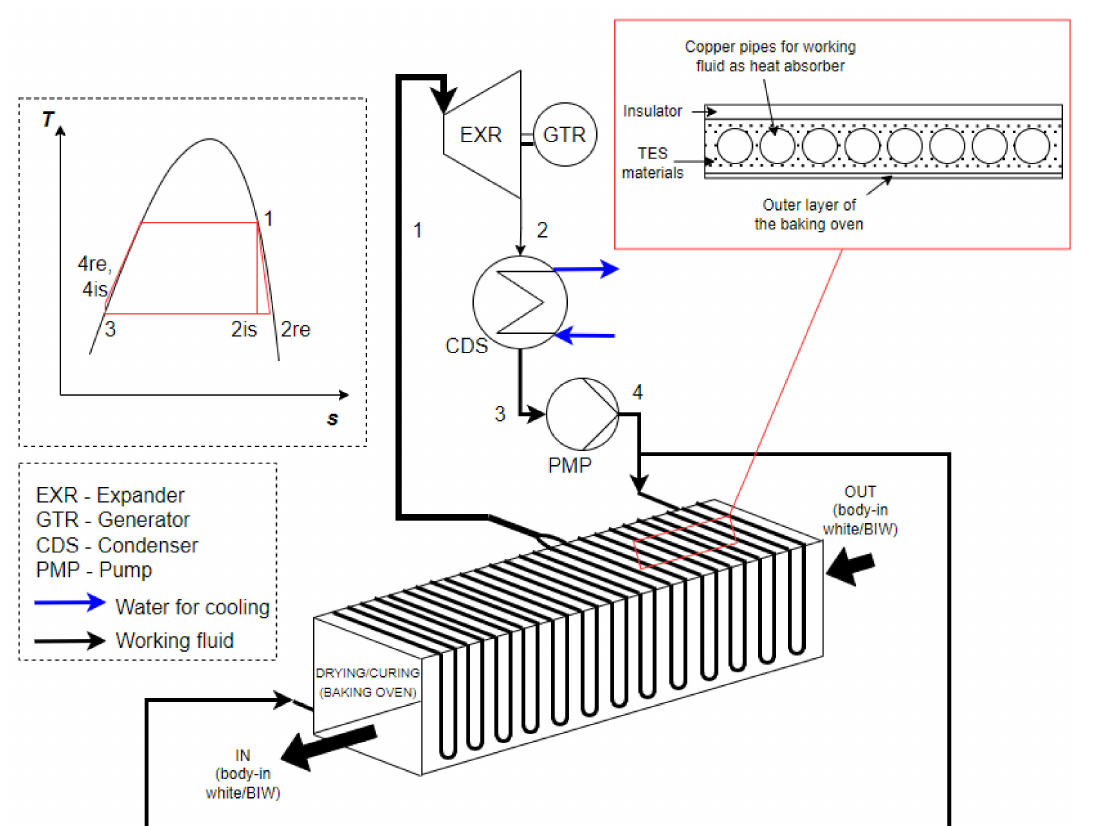
Figure 4. A schematic layout of investigated waste heat recovery system employing TES and